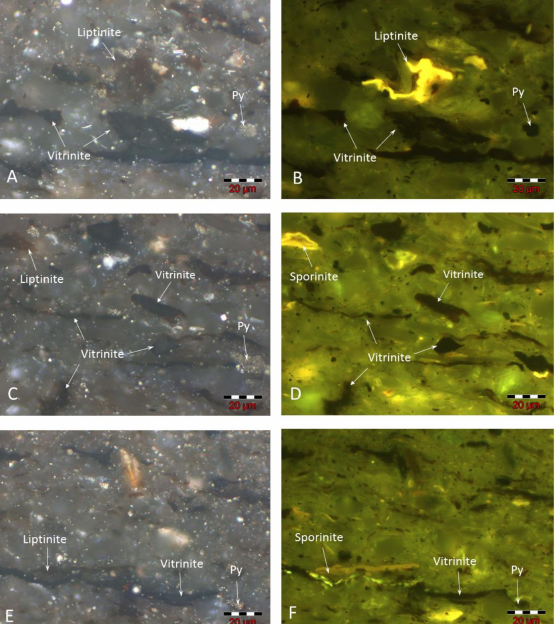
Figure 6. Photomicrographs of C-2 Socu Upper Badenian source rocks of the Getic Depression showing continental liptinite origin in a mineral carbonate groundmass with pyrite. Reflected light (RL: figures A , C , E ) and fluorescent light (FL: figures B , D , F ), oil immersion, 500 ×